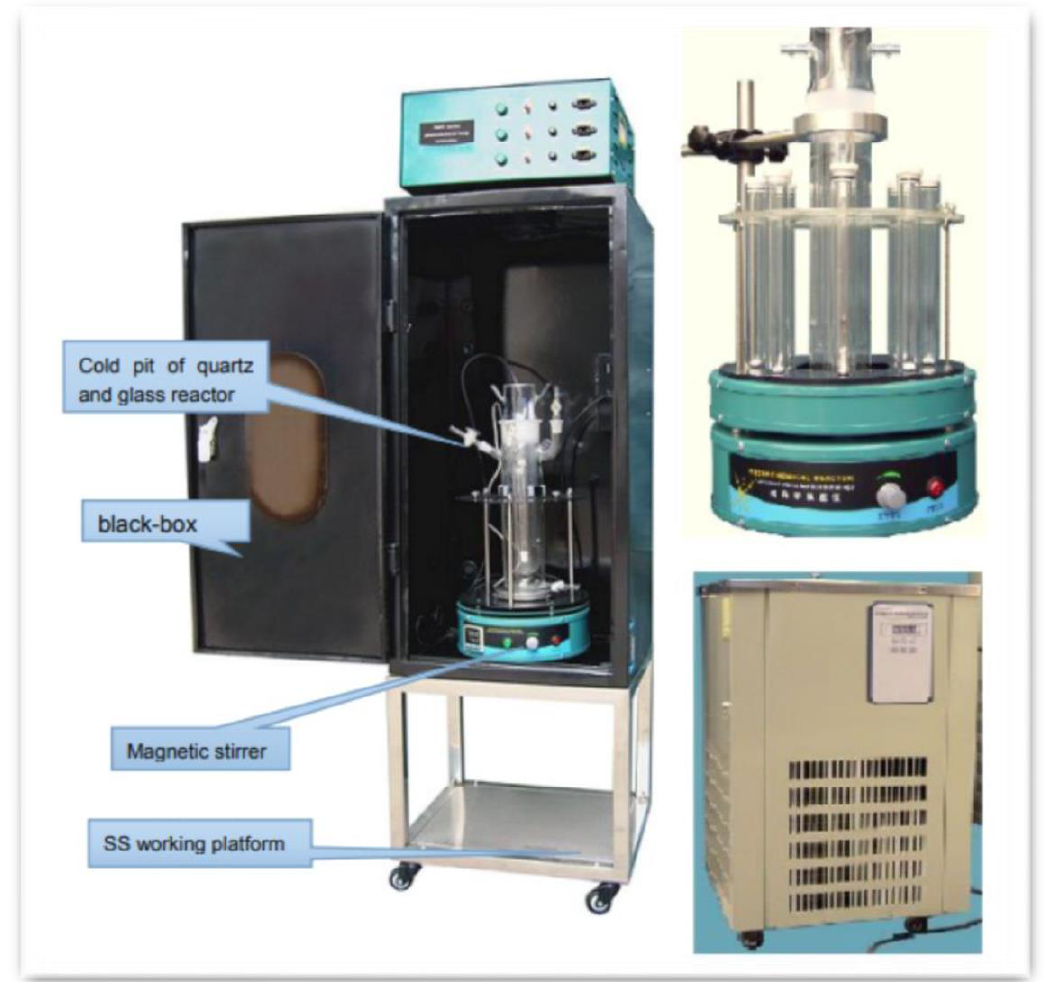
Figure 17. Photochemical reactor.